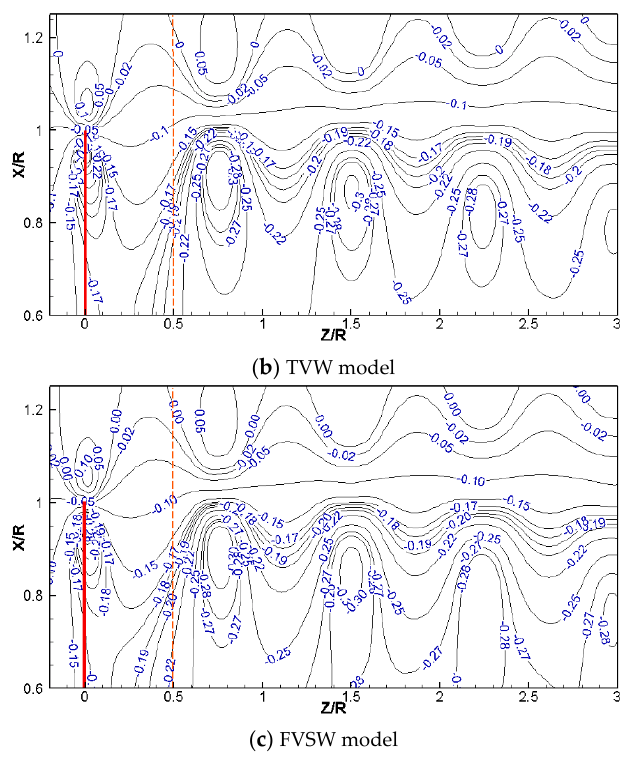
Figure 15. Contours of the axial induction factor.